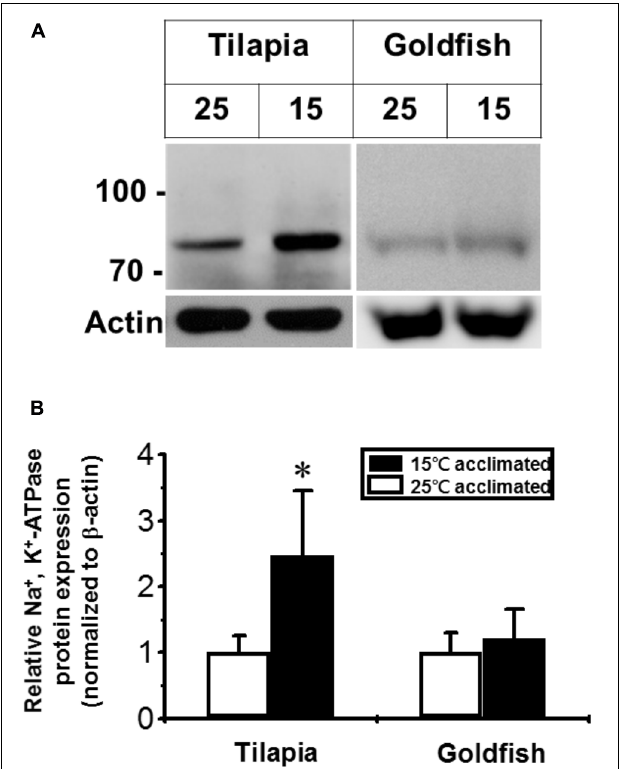
FIGURE 3 | Effect of cold acclimation on the expression of Na + /K + -ATPase in tilapia or goldfish gill. (A) The abundance of Na + /K + -ATPase was determined by western blotting analysis. Different numbers (25 and 15) indicated acclimation temperature ( ◦ C). The immunoblot for actin served as an internal control. (B) The quantification of the Na + /K + -ATPase expression. The Na + /K + -ATPase expression was normalized to β -actin and was also relative to 25 ◦ C acclimated group (set as 1). Values shown are mean ± S.D. ∗ Significant difference between 15 ◦ C and 25 ◦ C acclimated groups in the same species (Student’s t -test, p ≤ 0.05, n = 4).